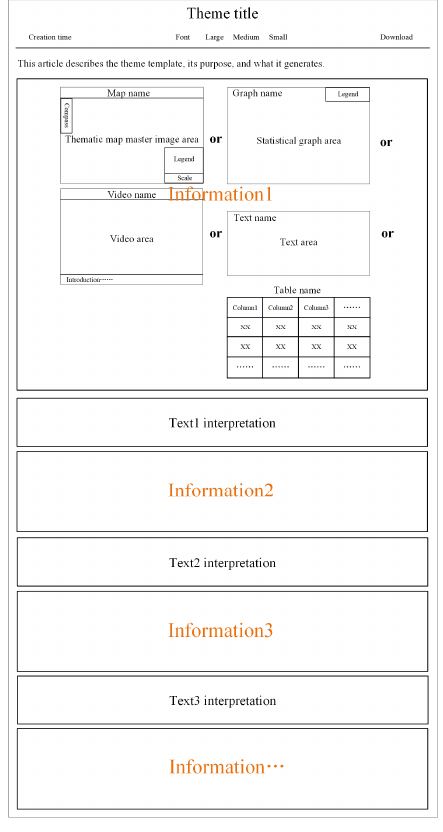
Figure 3. APP design diagram.